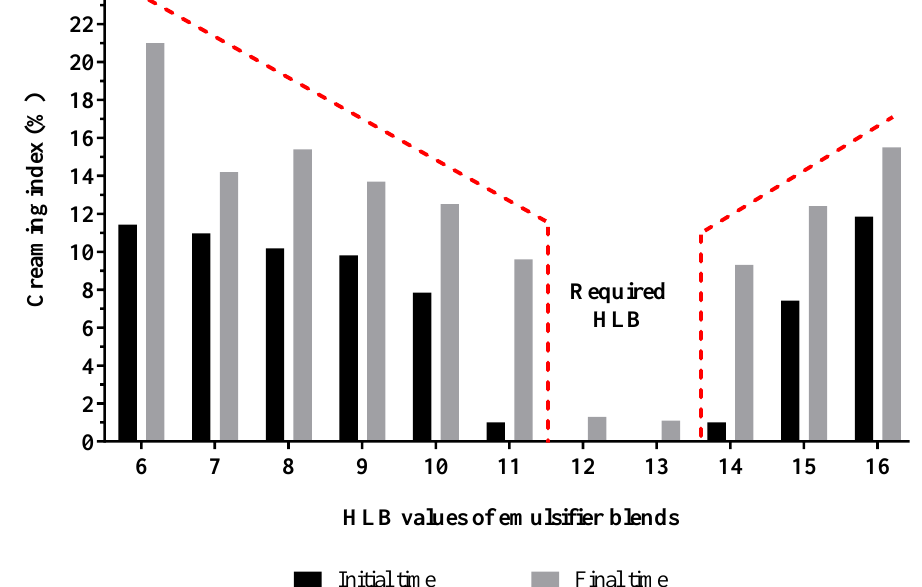
Figure 3. Results of the creaming index with respect to the hydrophilic–lipophilic balance (HLB) values of the cationic surfactant blends used for the emulsified prototypes.